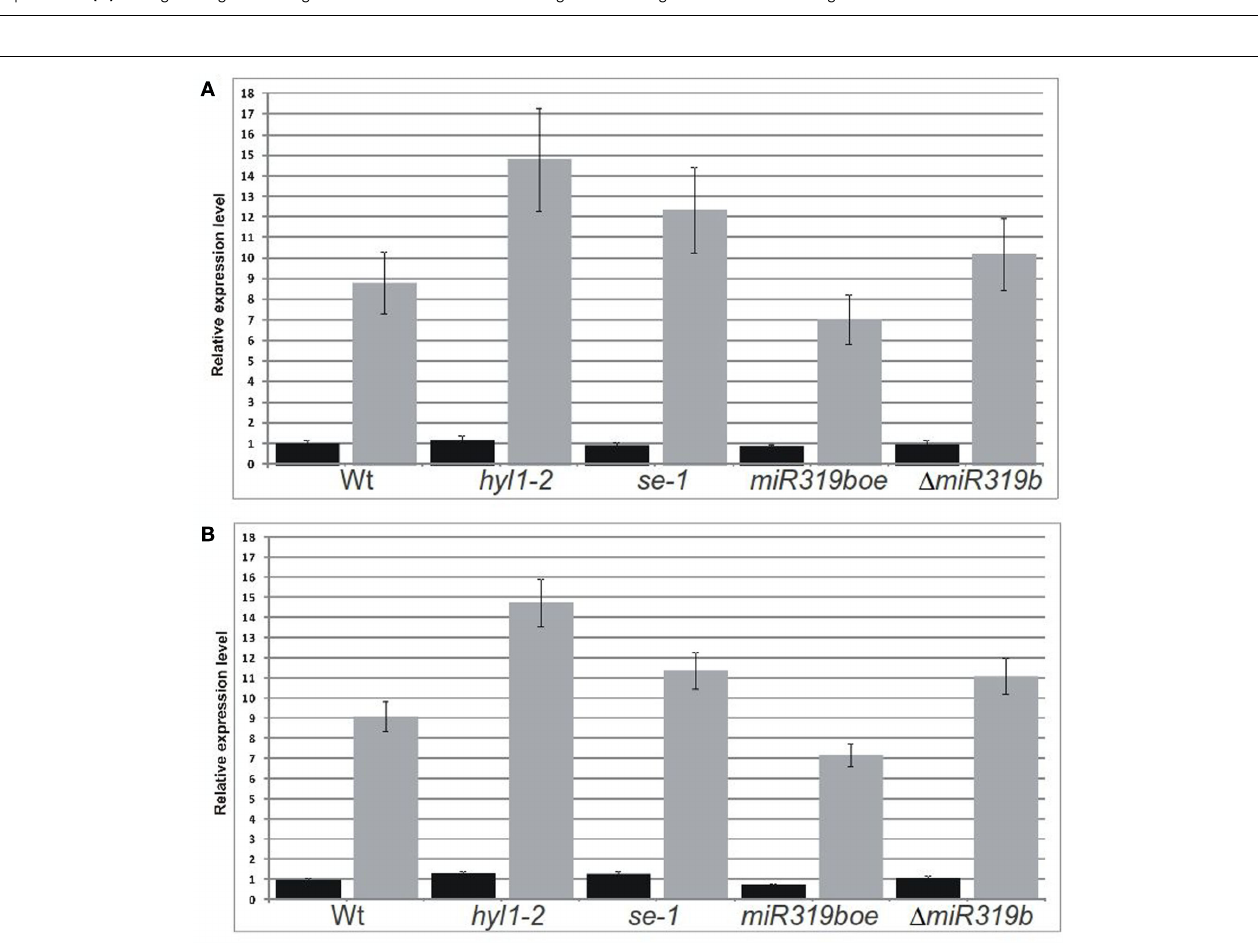
mRNA isoform cleavage products in wt plants, miR319boe , and Δ miR319b mutant plants. Arrow points to the expected length of 5 (cid:3) -RACE product, star depicts degradation products obtained during 5 (cid:3) -RACE. In each line, five 5 (cid:3) -RACE reaction products were pooled together and loaded on gel.